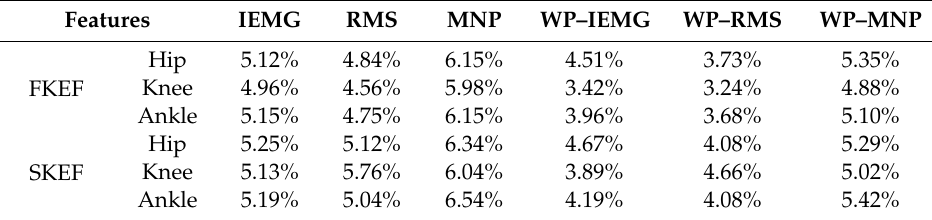
Table 4. RMSE with different input features.